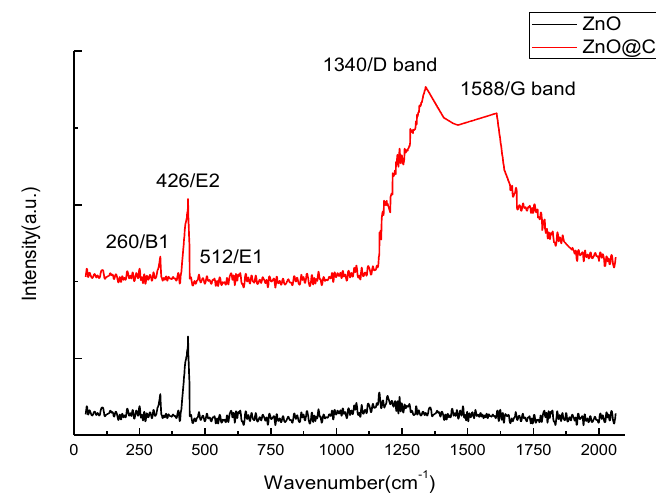
Figure 5. The Raman spectra of ZnO and carbon-coated ZnO nanorod powder. The Raman spectrum of ZnO was labeled according to the B1, E2, and E1 vibration modes, and those of carbon are D and G.